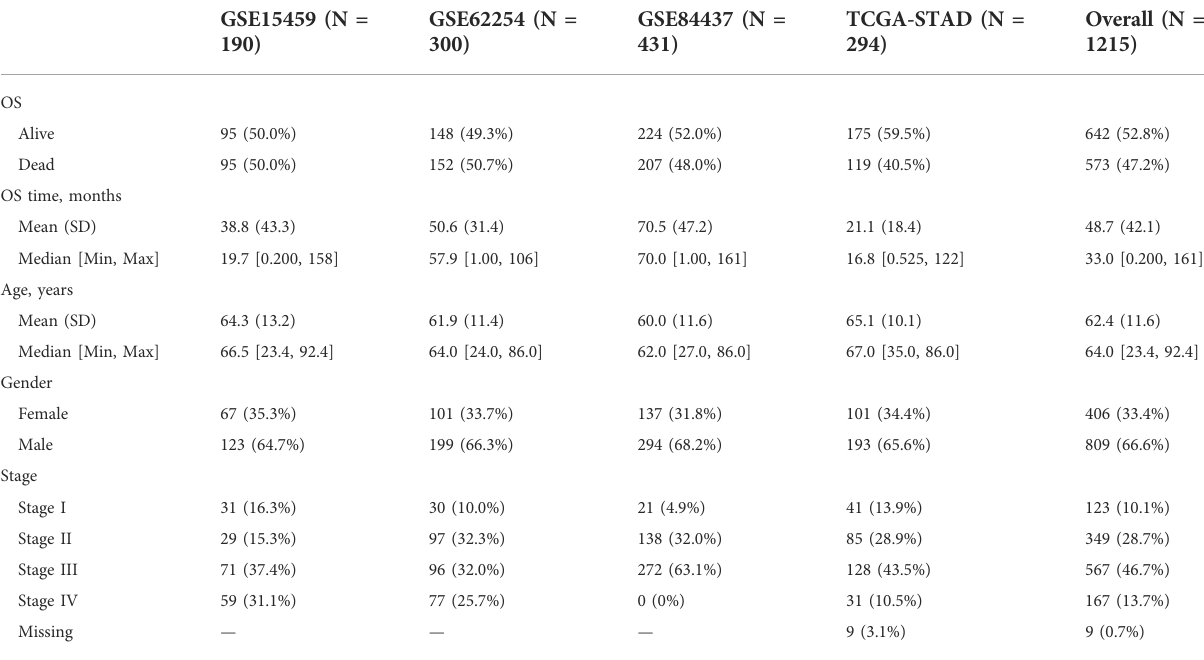
TABLE 1 Clinical features for the enrolled three